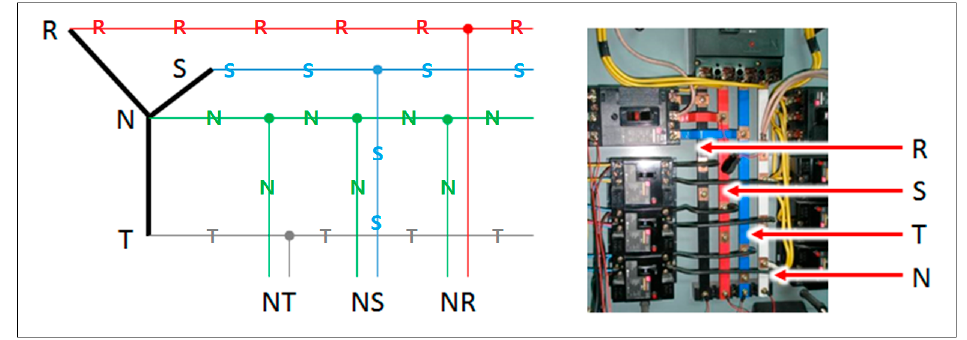
Figure 1. Three-phase four-wire Y-connection (land-use power line structure).